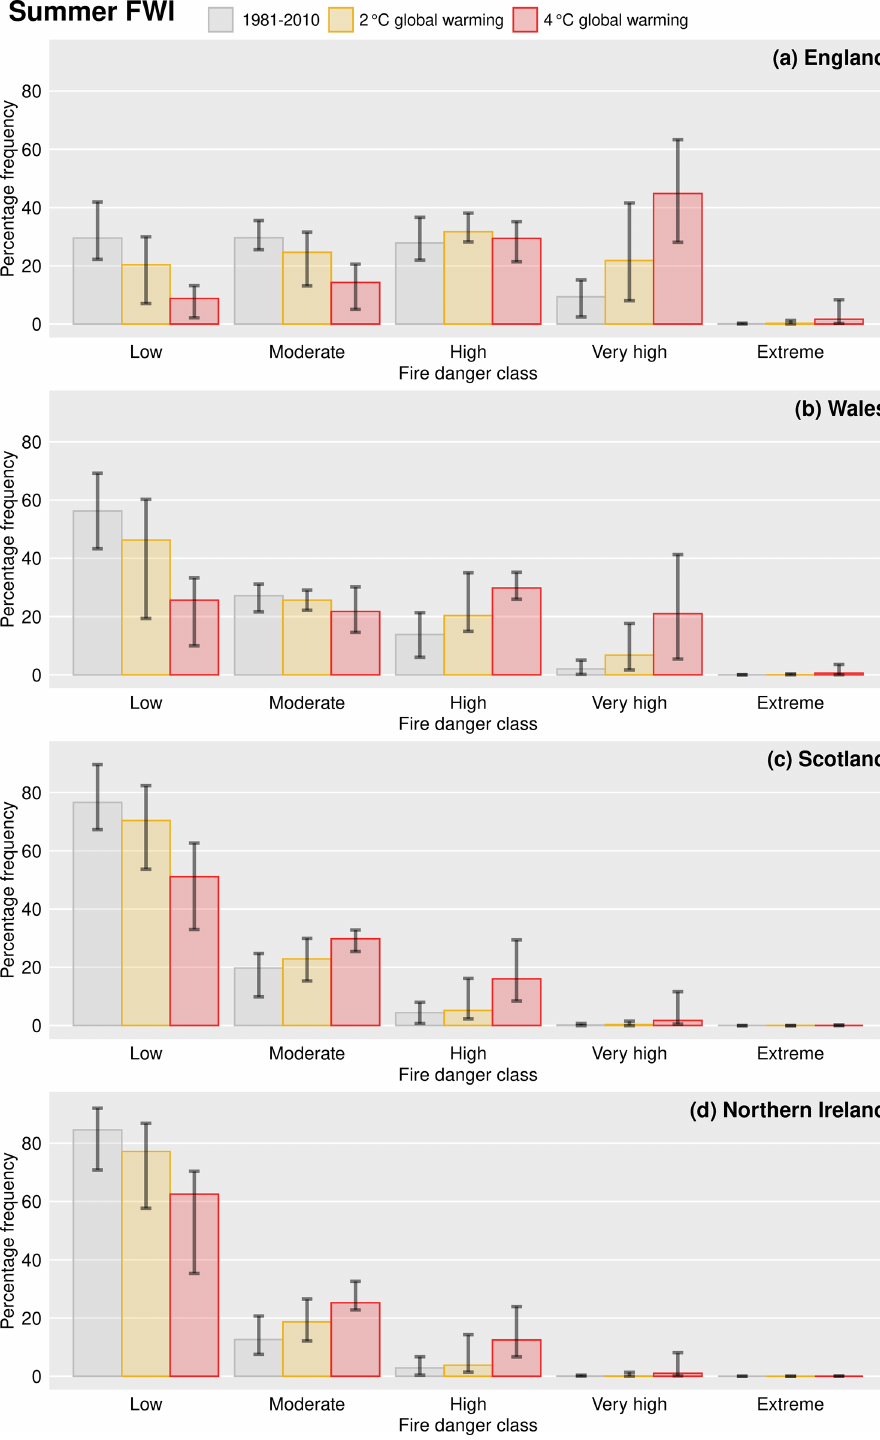
Figure 7. As Fig. 6, but for summer fire danger classes based on the daily 95th percentile FWI. The exceptional danger level has been encompassed into a broader extreme danger level with FWI >